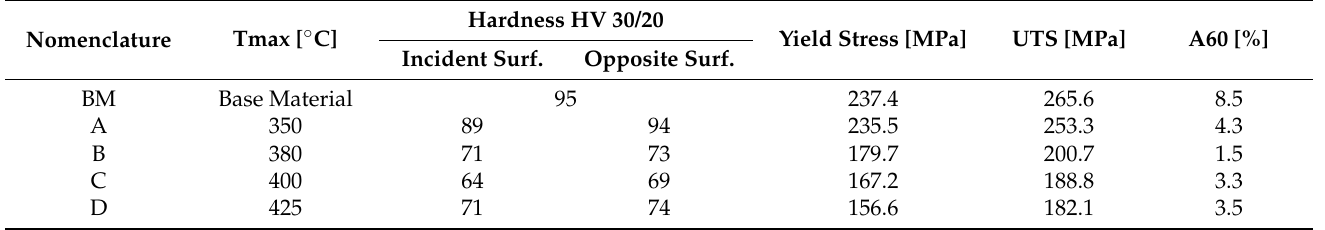
Table 3. Mechanical property modification based on heat treatment maximum temperatures